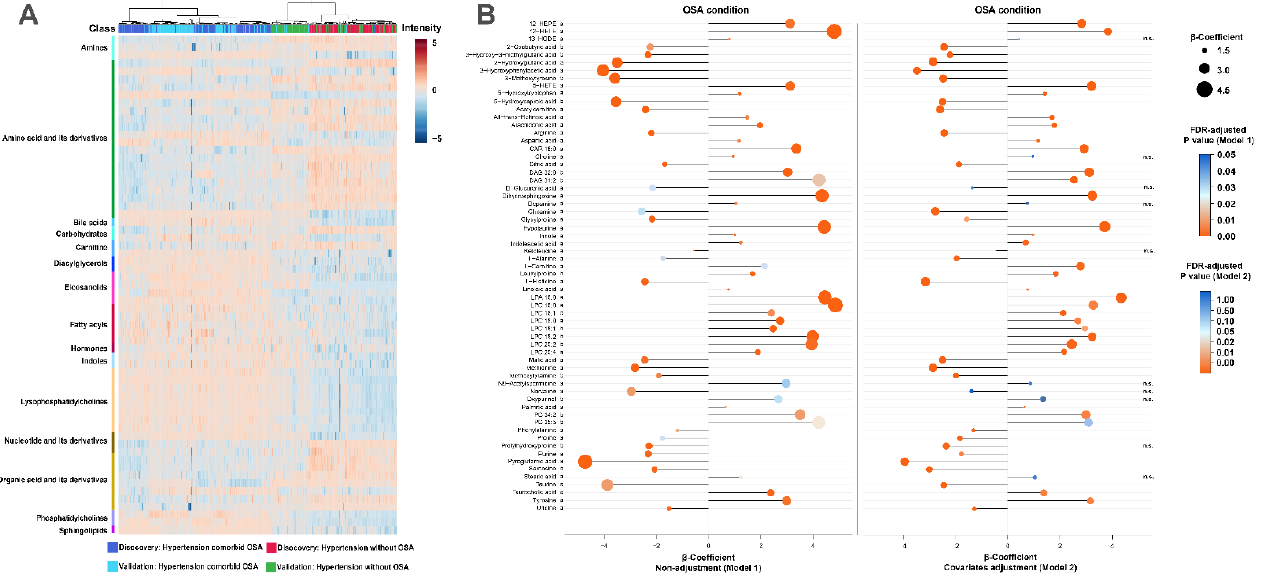
Figure 3. Metabolic changes associated with hypertension comorbid OSA. ( A ) Heat map of the datasets of differential metabolites, indicating that the expressed trends of most differential metabo- lites that distinguished patients with hypertension comorbid OSA from non-OSA hypertensive patients were similar in the discovery and validation sets. ( B ) Regression analysis plot depicting the association of each metabolite and OSA condition; positive or negative β -coefficient values indicate a positive or negative correlation between metabolites and OSA condition, FDR-adjusted p < 0.05 was considered as significant threshold, n.s. represents no significance. a and b indicates if the metabolites are annotated by chemical-standards or not. Model 1: Univariate regression analysis; Model 2: Adjustments for changed clinical variables and commonly known metabolic factors, including ages, sex, BMI, neck circumference, waist circumference, hip circumference, waist-to-hip ratio, night-time SBP, night-time DBP, TC, HDL-C. C Pathway enrichment analysis of the differentiated metabolites by using